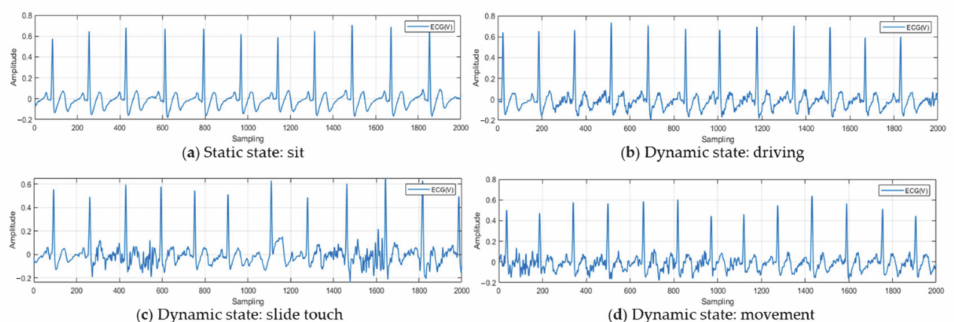
Figure 4. ECG acquired according to driver state: ( a ) static state: sit ( b ) dynamic state: driving ( c ) dynamic: slide touch ( d ) dynamic state: movement.